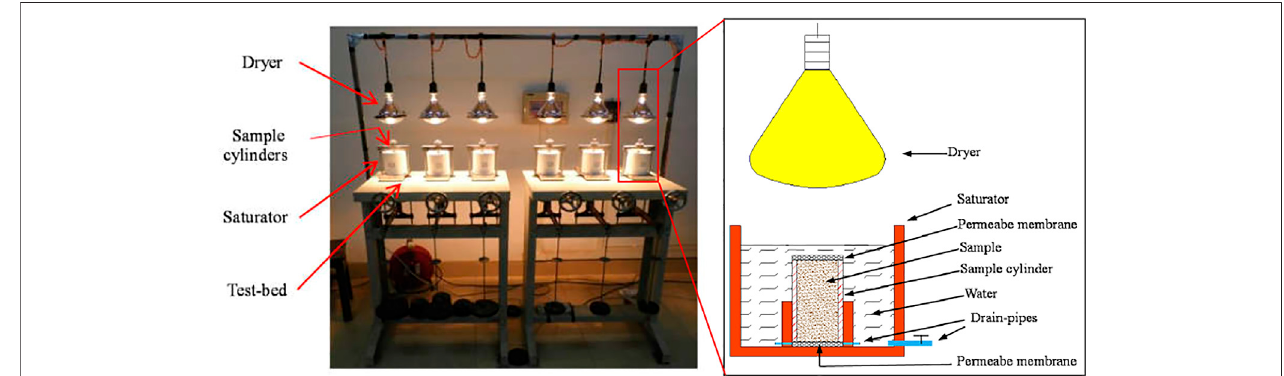
FIGURE 2 | Self-made test apparatus of wetting – drying cycles.